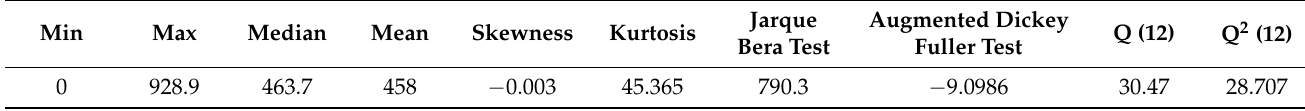
Table 4. Descriptive statistics and preliminary tests.